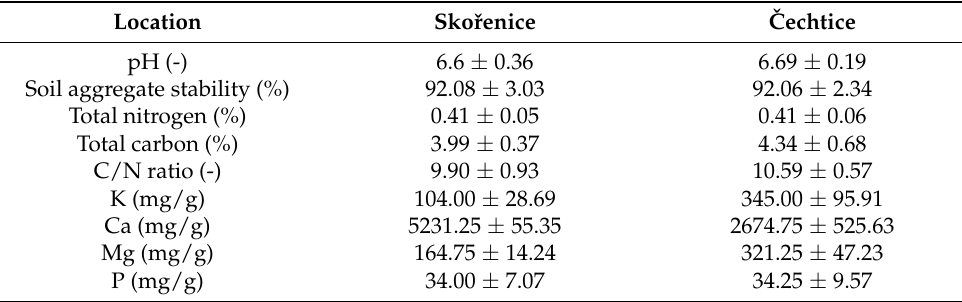
Table 1. Soil physical and chemical parameters of experimental